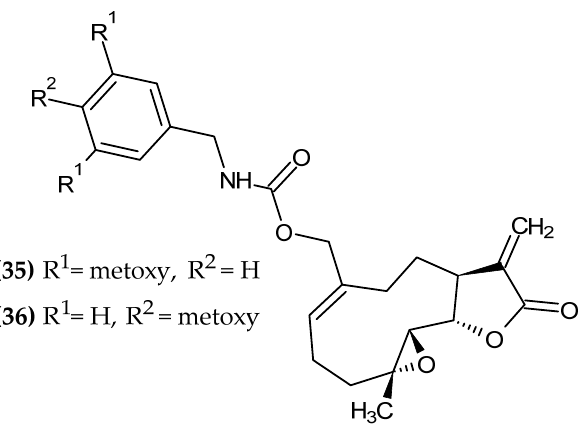
Figure 8. Sesquiterpene lactone derivatives with anti-melanoma